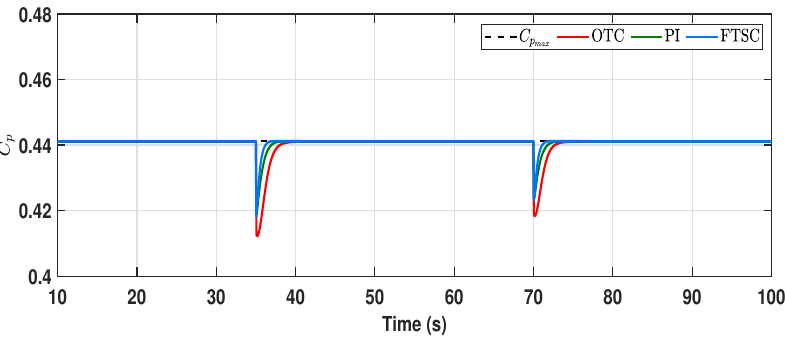
Figure 10. Comparative evaluation of power coefficient ( C p ) under step wind